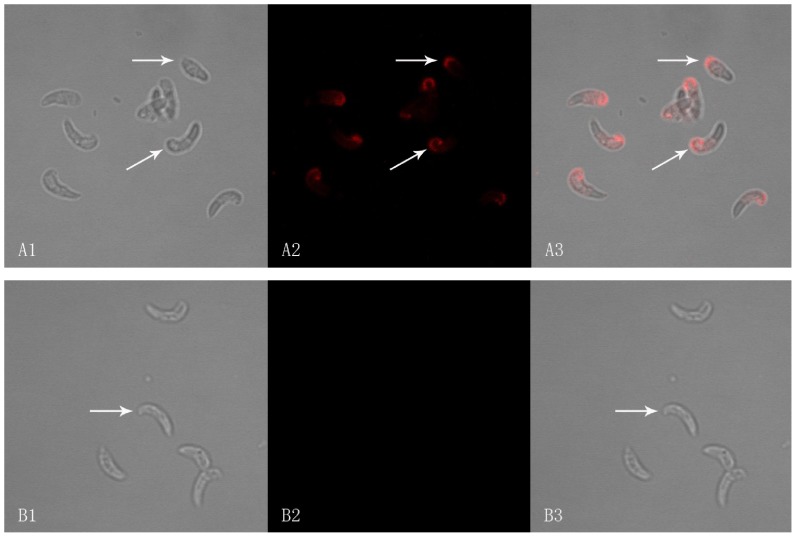
Expression of EaMIC5 protein in E. acervulina sporozoites by immunofluorescence assay (×100 magnification).Panel A: E. acervulina sporozoites. The white arrows indicate sporozoites. (A1) Differential interference contrast (DIC). (A2) Immunofluorescence localization using Cy3. (A3) DIC and Immunofluorescence combined. Panel B:Negative control, the sporozoites were probed by serum of normal rat without immunizing as primary antibody. (B1) DIC. (B2) Cy3. (B3) Combined.